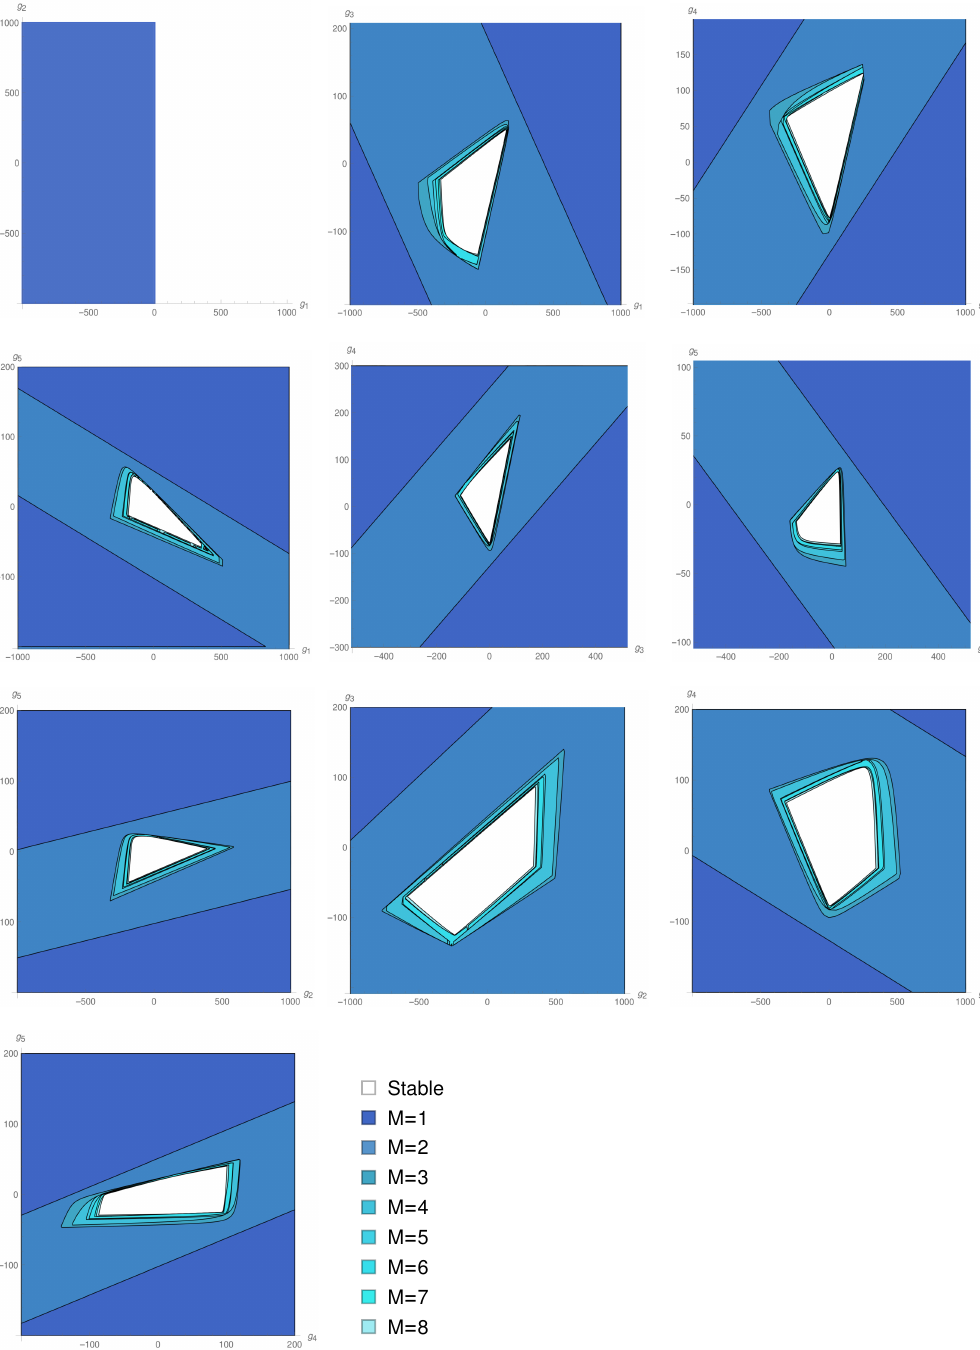
Figure 2 . Phase diagrams showing the unstable regions in the five-dimensional coupling space g 1 , g 2 , g 3 , g 4 , g 5 . Each plot corresponds to one of the ten two-dimensional coupling planes. We see that there is an island of stability around the origin. The lighter regions become unstable at higher M . The plots correspond to ˆ m = 0 . 4 , λ = 2 and γ = 100 (see appendix E for details on these